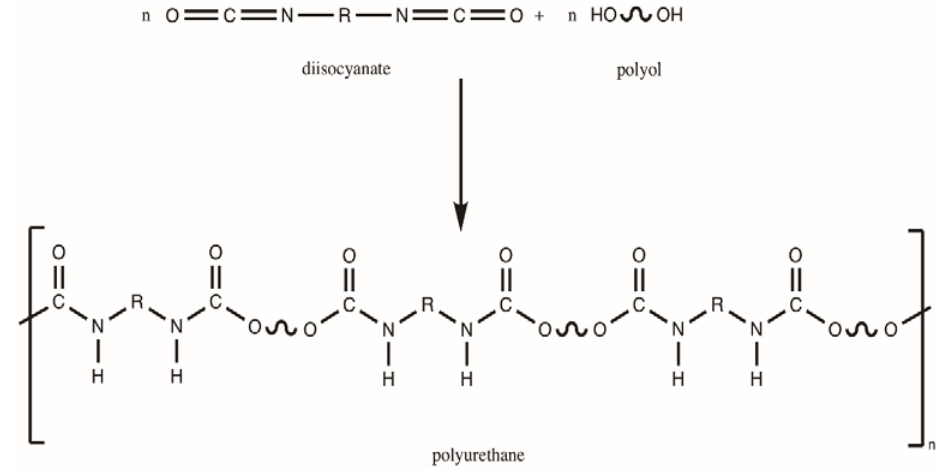
Figure 1. Scheme of preparation of polyurethane.